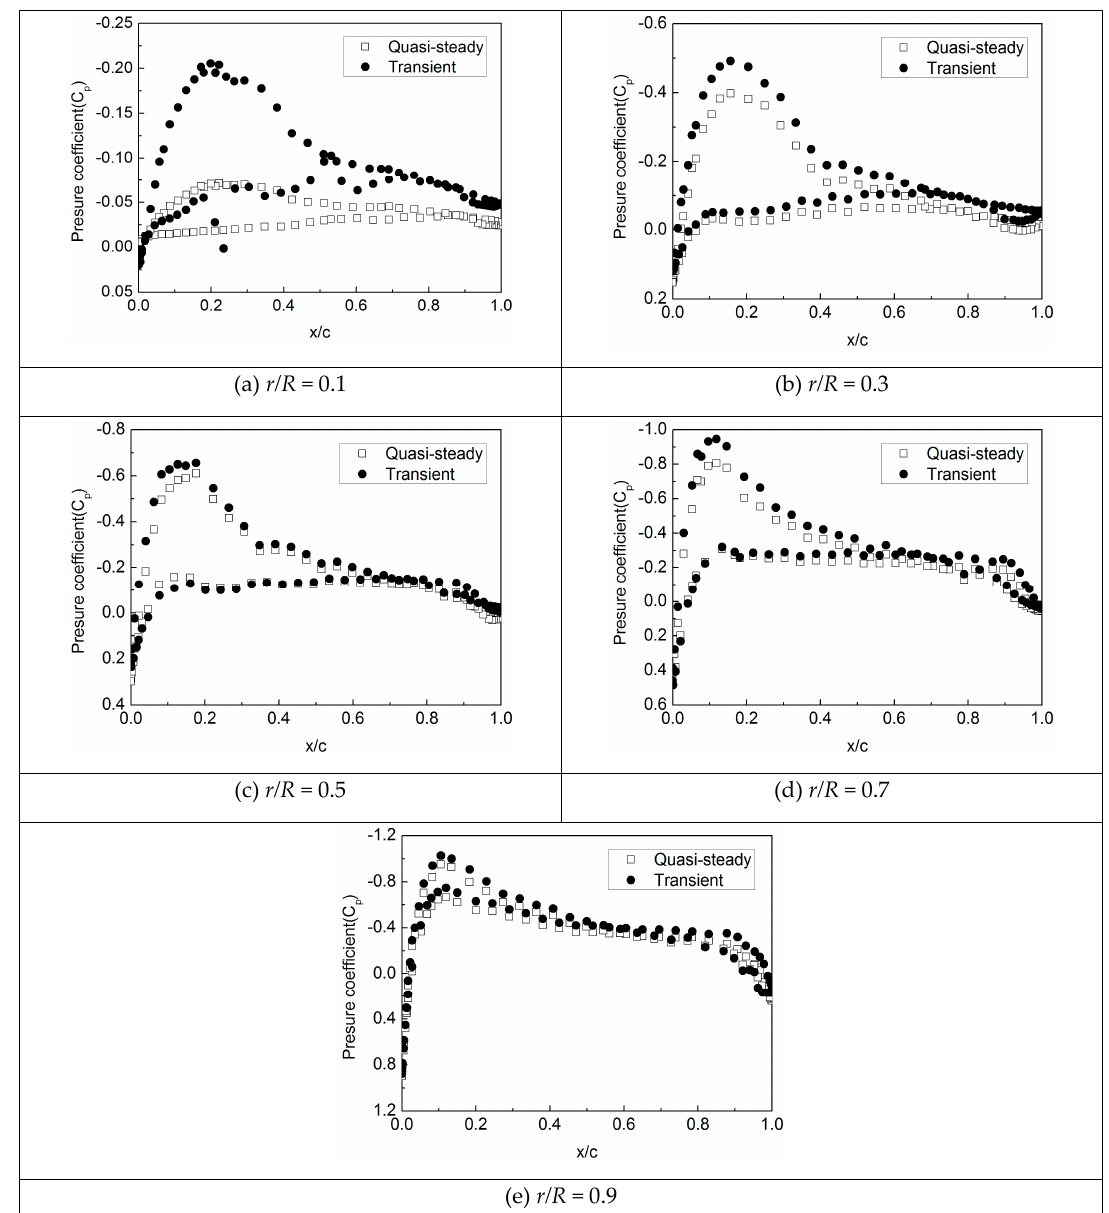
Figure 12. Pressure coefficient distributions at several radial positions on the blade obtained by both methods. (a) r/R = 0.1; (b) r/R = 0.3; (c) r/R = 0.5; (d) r/R = 0.7;(e) r/R = 0.9 methods. ( a ) r/R = 0.1; ( b ) r/R = 0.3; ( c ) r/R = 0.5; ( d ) r/R = 0.7;( e ) r/R =